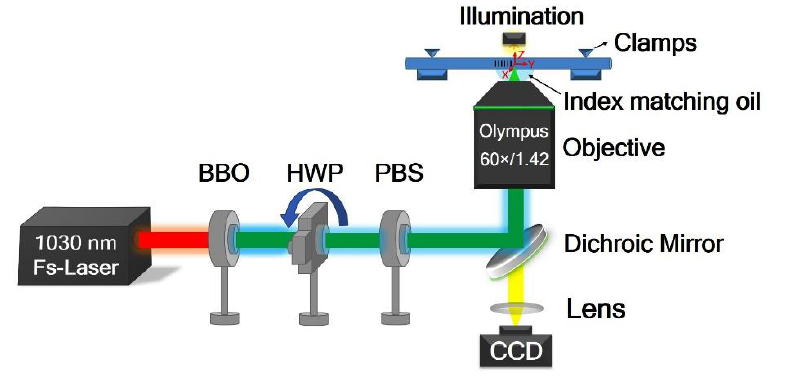
Figure 1. Schematic diagram of the device for fabricating apodized FBGs based on energy regulation method.